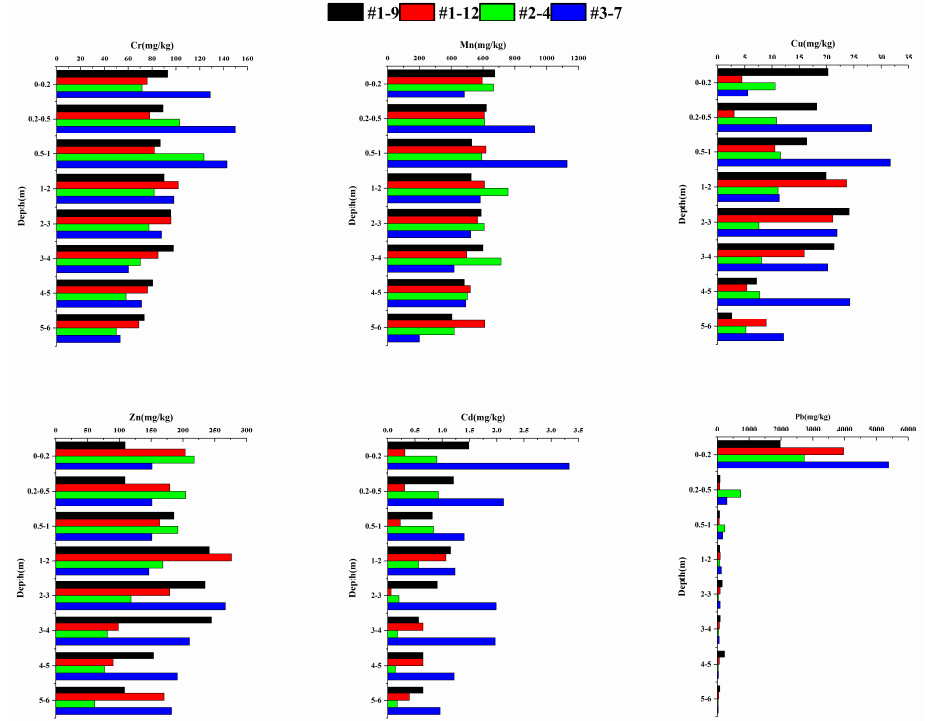
Figure 3. Statistics pertaining to HM concentration with depth.